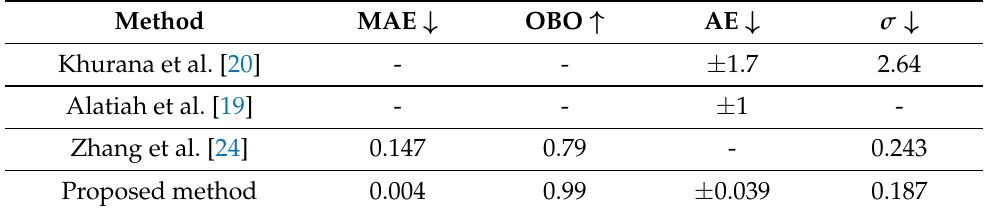
Table 6. Counting accuracy comparison between the four works. Khurana’s work is based on 17 exercises gathered from a gym camera. Alatiah’s research and Zhang’s work leverage data from UCF101 dataset with 3 exercises and 24 daily activities individually. Our paper includes 7 exercises, and the data are originally derived from PennAction dataset.